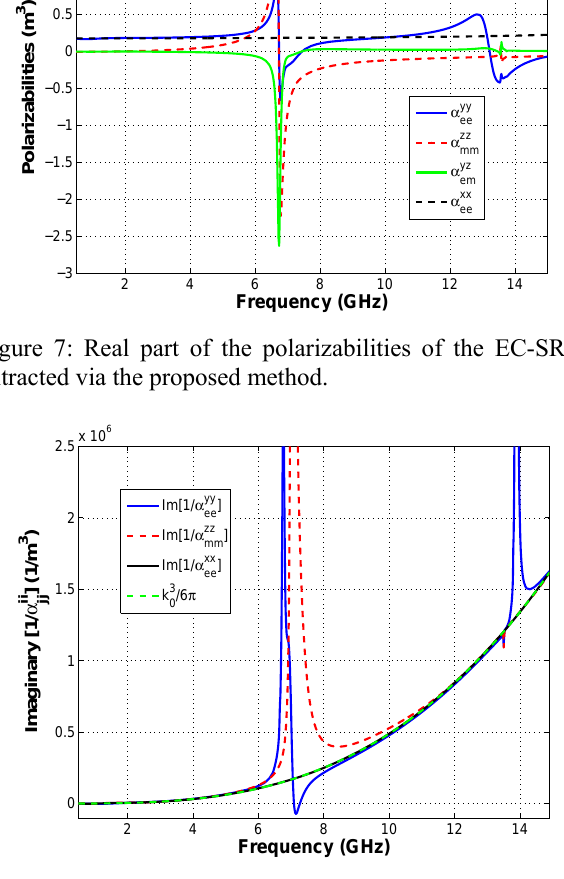
Figure 8: Comparison of the Sipe-Kranendonk criterion for lossless scatterers with the polarizabilities of the EC-SRR extracted in Fig. 7. The criterion is not satisfied on reso- nance bands, where the anisotropic assumption is not